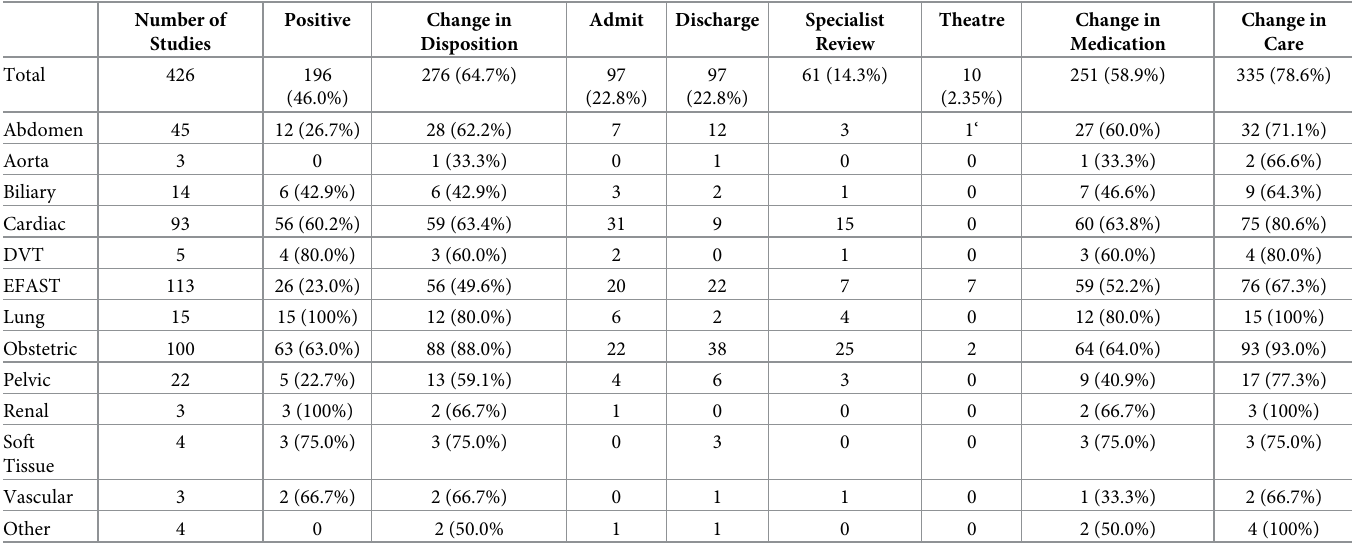
Table 2. Overall effect of ultrasound on patient care.